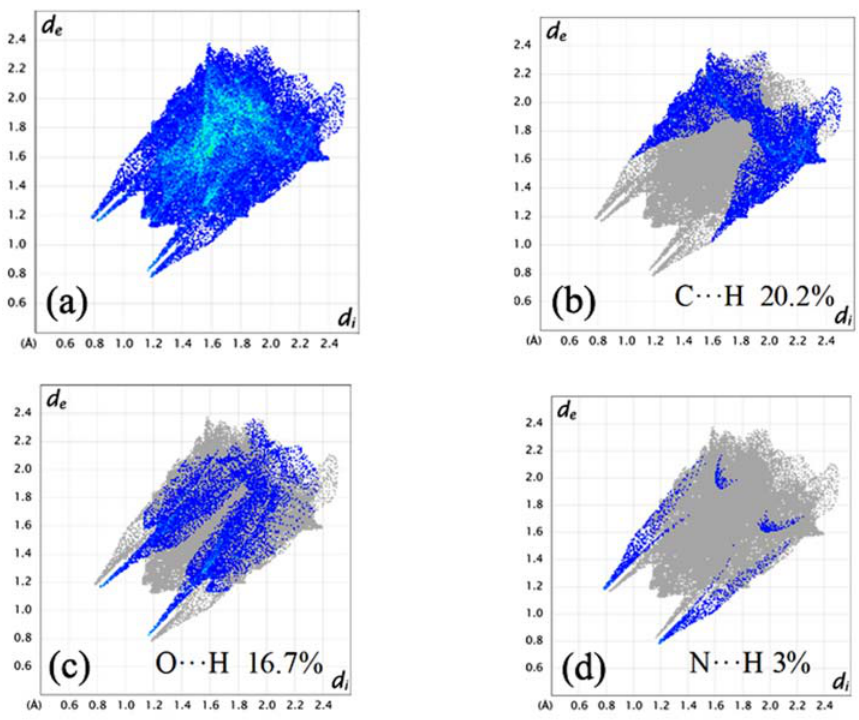
Fig. 10. 2D Finger print plot of Str 158 with a) 100% contribution of all elements b) 20.2% of C···H/H···C interaction c) 16.7% O···H/H···O interac- tion d) 3% of N···H/H···N